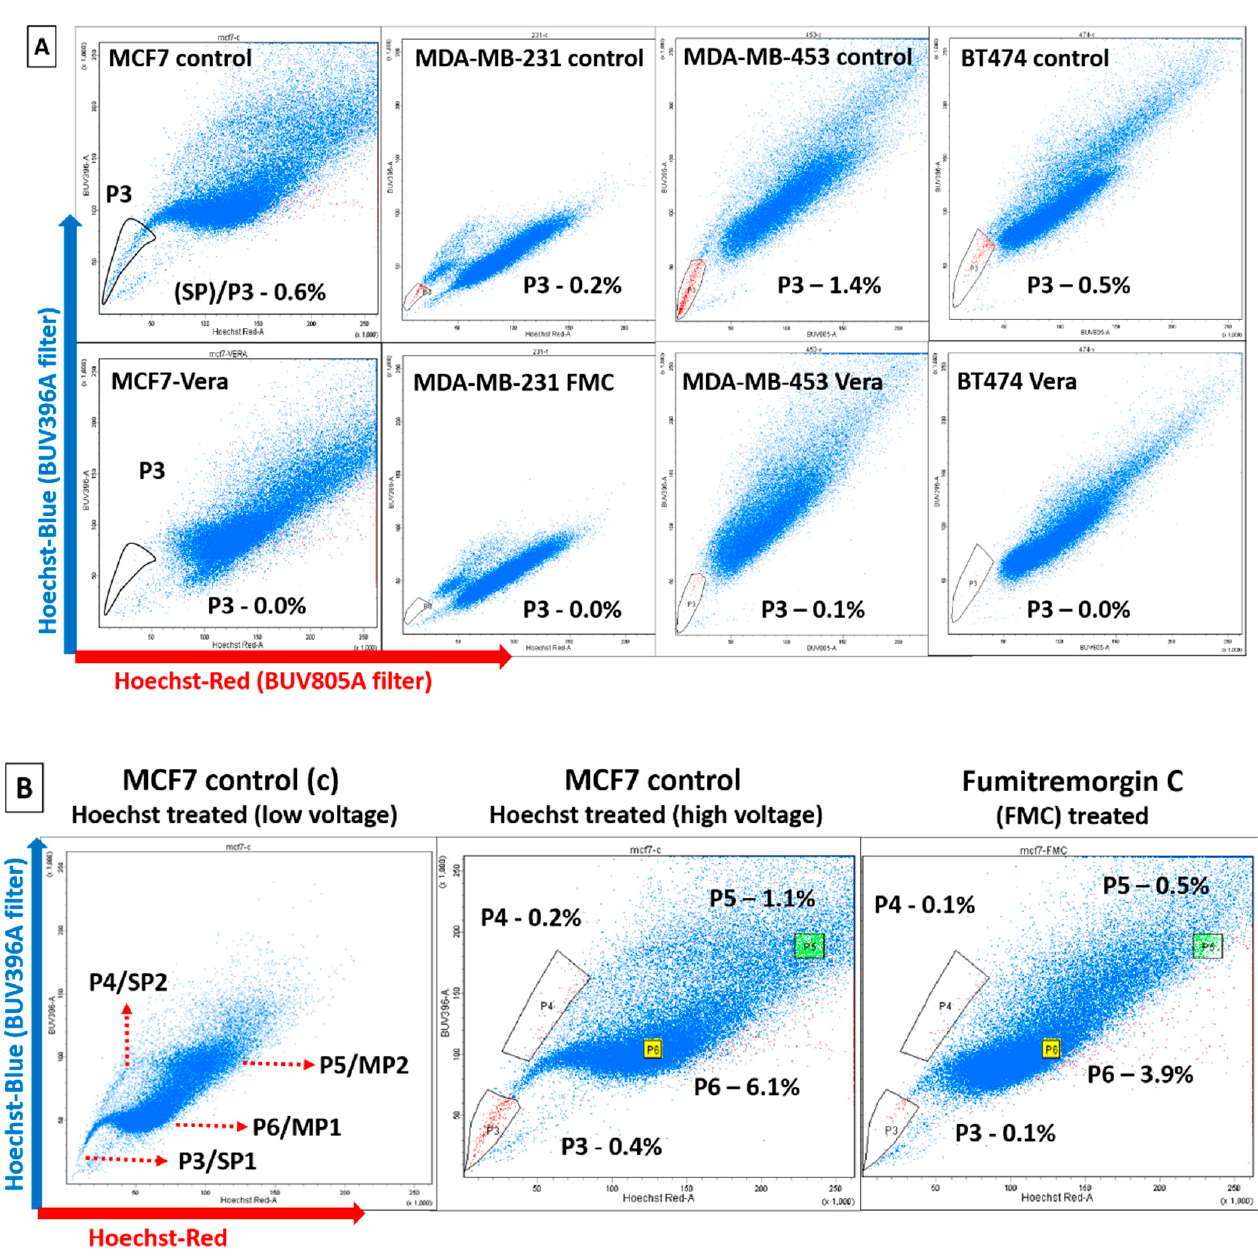
Figure 2. Screening for dye effluxing fractions in breast cancer. ( A ) Hoechst dye efflux activity was displayed by cancer cells across all four major breast cancer subtypes. Hoechst low side population (SP cells gated in P3) and Hoechst high brighter cells retaining the dye were the non-side population cells. The identity of the SP fraction was confirmed via treatment with the drug transporter protein inhibitors verapamil (Vera) and fumitremorgin C (FMC). ( B ) Predominantly, the MCF7 cells displayed a higher percentage of Hoechst low cells as two separate fractions differing in their DNA content (dual side population fractions SP1 (gated in P3) and SP2 (gated in P4)) within the hummingbird pattern and were chosen for additional experiments. Corresponding Hoechst high dye-retaining non-side population cells (MP1 gated in P6 and MP2 gated in P5) were also selected for comparison. 2.4. Orthotopic Breast Tumor Regeneration Potential in NSG Mice Hoechst-dye-treated MCF7 cells sorted into SP1, SP2, MP1, and MP2 fractions at a final count of 1 × 10 5 viable cells per fraction were injected orthotopically into the